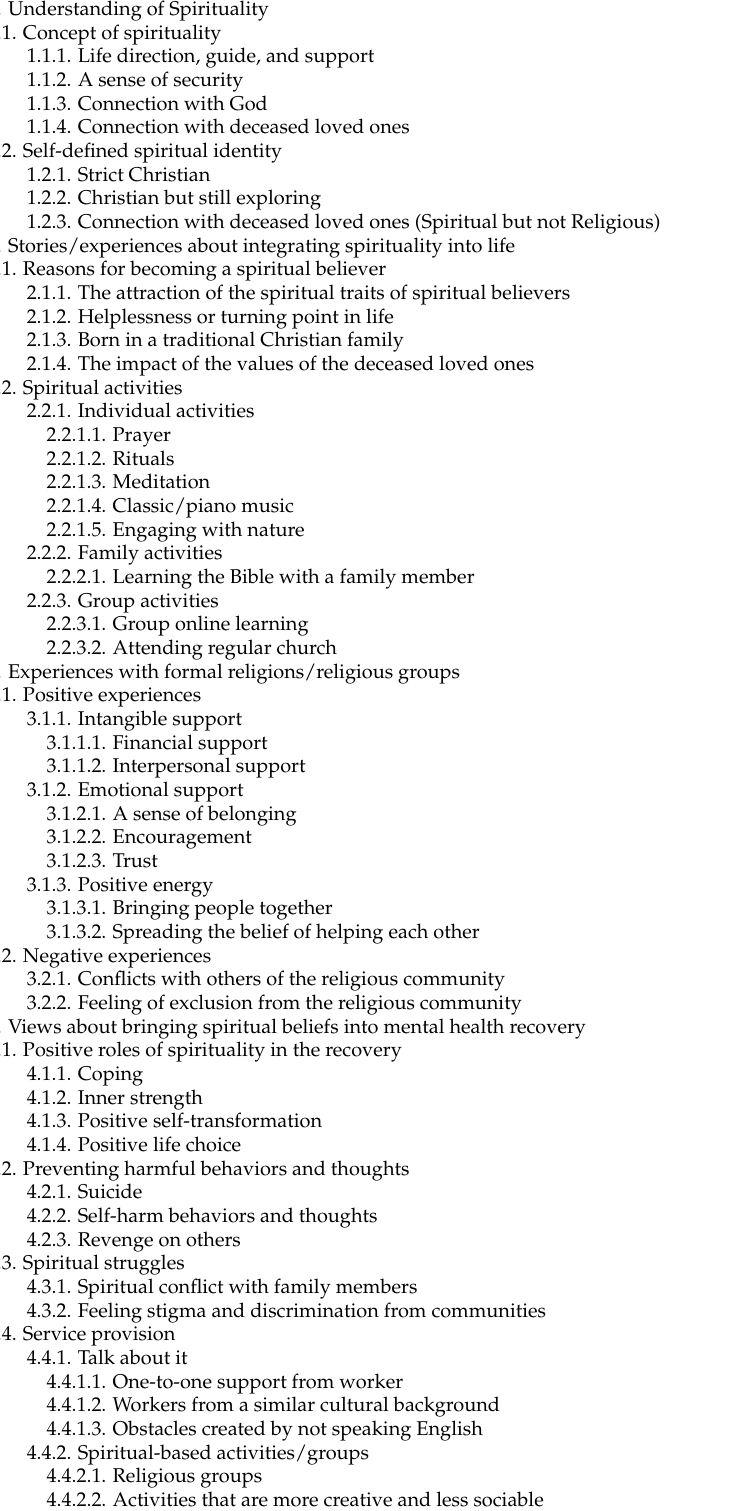
Table 1. Final template